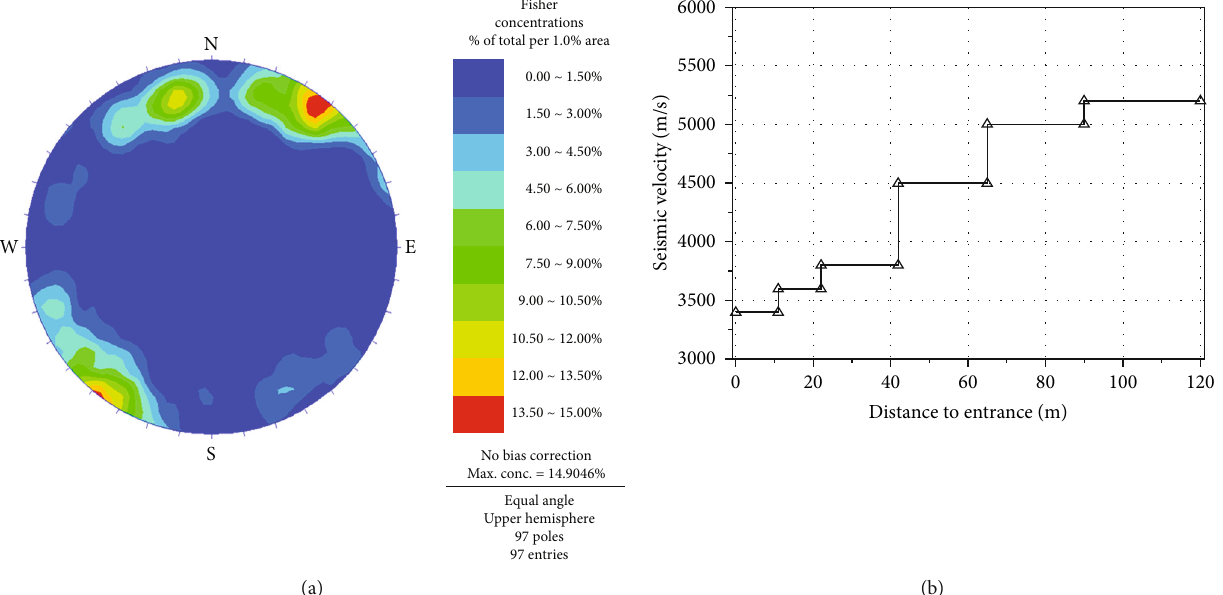
Figure 8: Micro fi ssures and seismic velocity in adit PD37: (a) isodensity map and (b) seismic wave velocity.